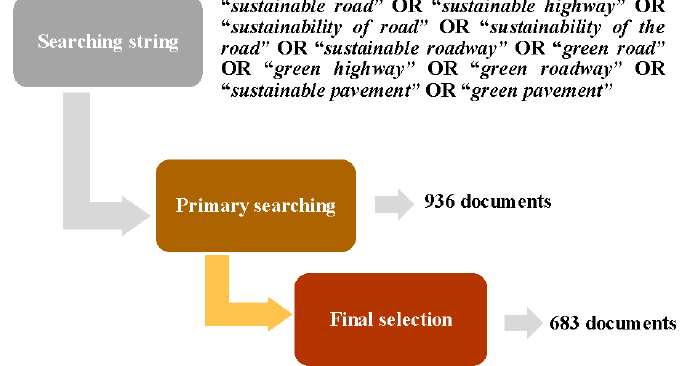
Figure 2. Results of the application of PRISMA flowchart.